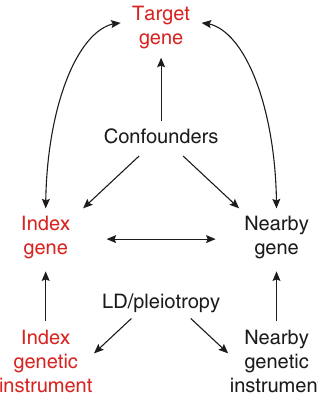
Fig. 1 Diagram showing the presumed relations between each variable. A directed arrow indicates the possibility of a causal effect. For instance, the index genetic instrument represents nearby SNPs with a possible effect on the nearby gene (analogous to cis -eQTLs). A double arrow means the possibility of a causal effect in either direction. The index gene, for example, could have a causal effect on the target gene, or vice versa. We aim to assess the presence of a causal effect of the index gene on the target gene using genetic instruments (GIs) that are free of non-genetic confounding. To do this, we must block the back-door path from the index GI through the GIs of nearby genes to the target gene. This back-door path represents linkage disequilibrium and local pleiotropy and is precluded by correcting for the GIs of nearby genes. Correction for observed gene expression (either of the index gene or of nearby genes) does not block this back-door path, but instead possibly leads to a collider bias, falsely introducing